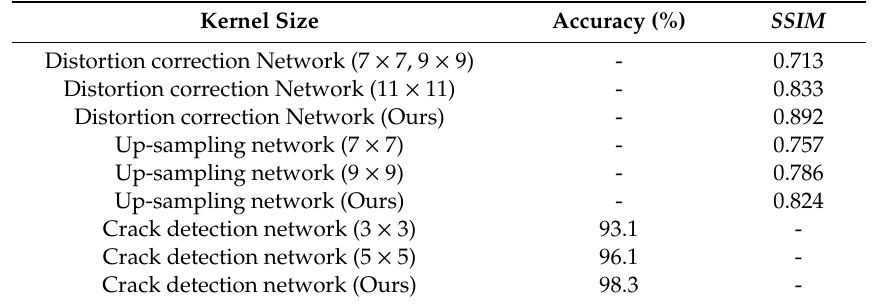
Table 4. The network of di ff erent steps in this system was a ff ected by the size of the convolution kernel.